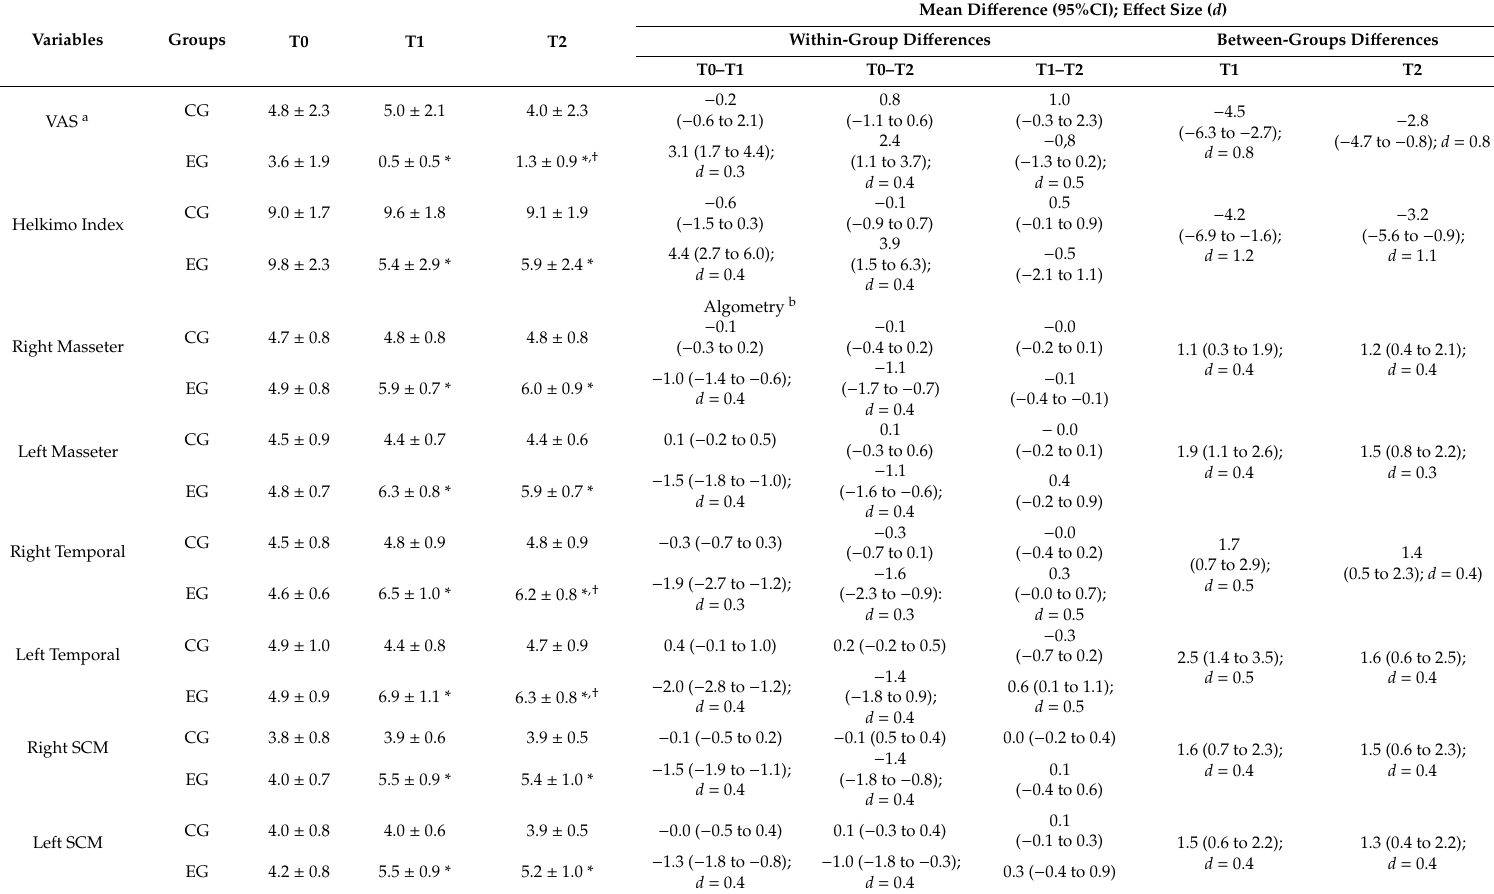
Table 3. Measurements of VAS, Helkimo, Algometry, and comparison